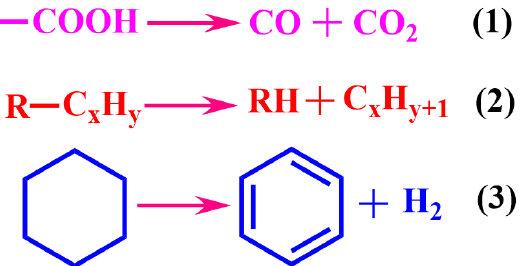
Figure 2. Pyrolysis process of heavy oil. Reprinted with permission from Ref. [16]. Copyright 2017, copyright Elsevier.